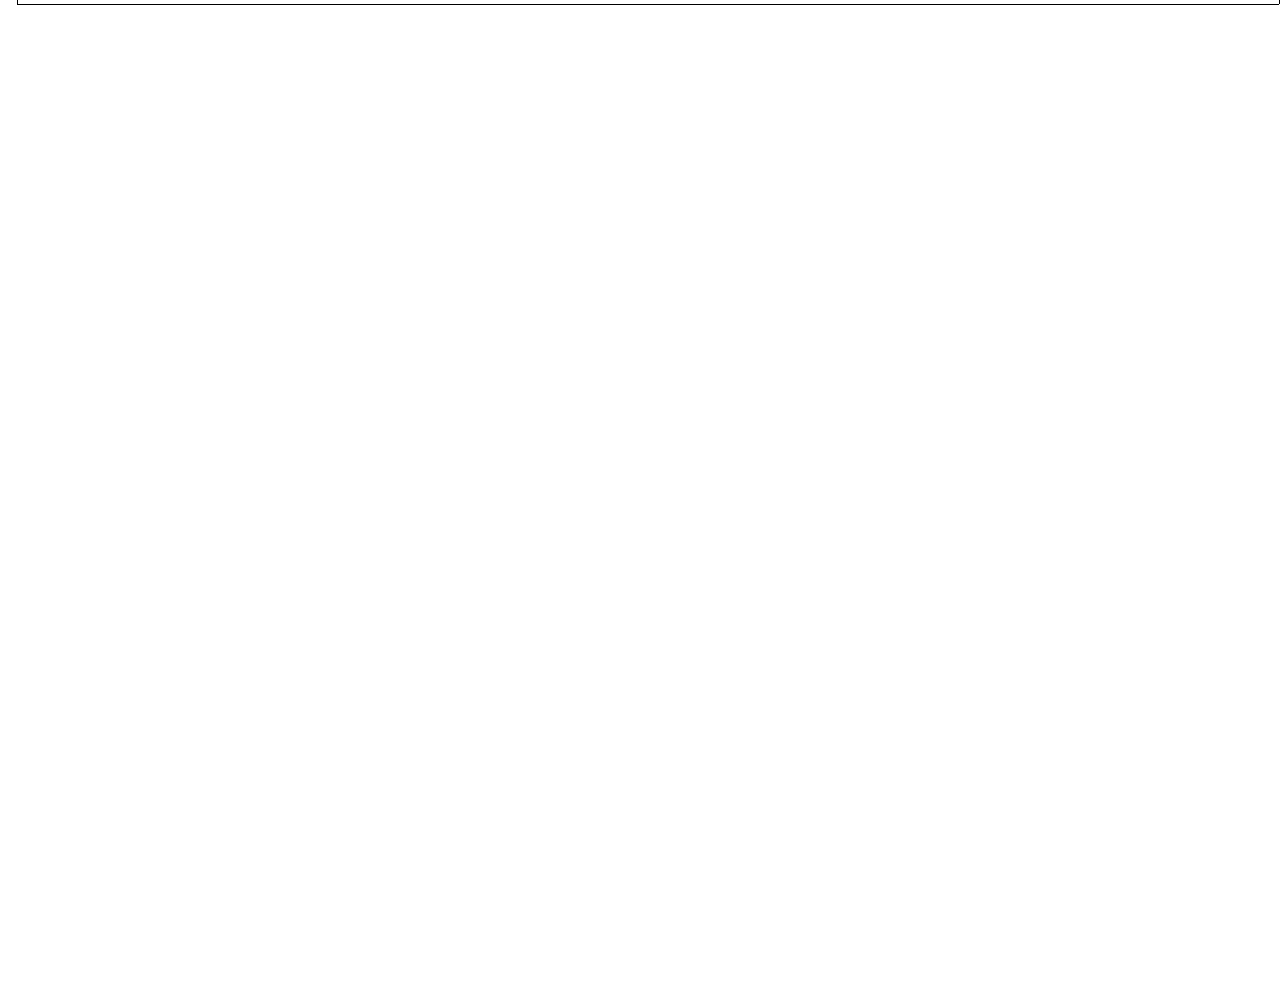
FIGUREA1 | Protein sequence alignments for (A)AtIRX9 andAtIRX9L, and (B)AtIRX14 and the respective closely related rice genes. Amino acids with blue shading and yellow lettering are 100% conserved compared to AtIRX9 and AtIRX14,